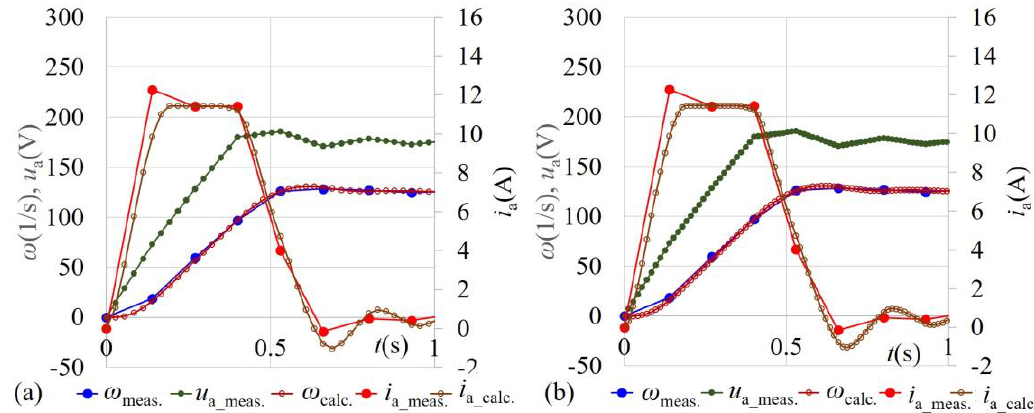
Figure 18. Measured and calculated responses in the case of MD1 using: ( a ) EM5; ( b ) EM10.